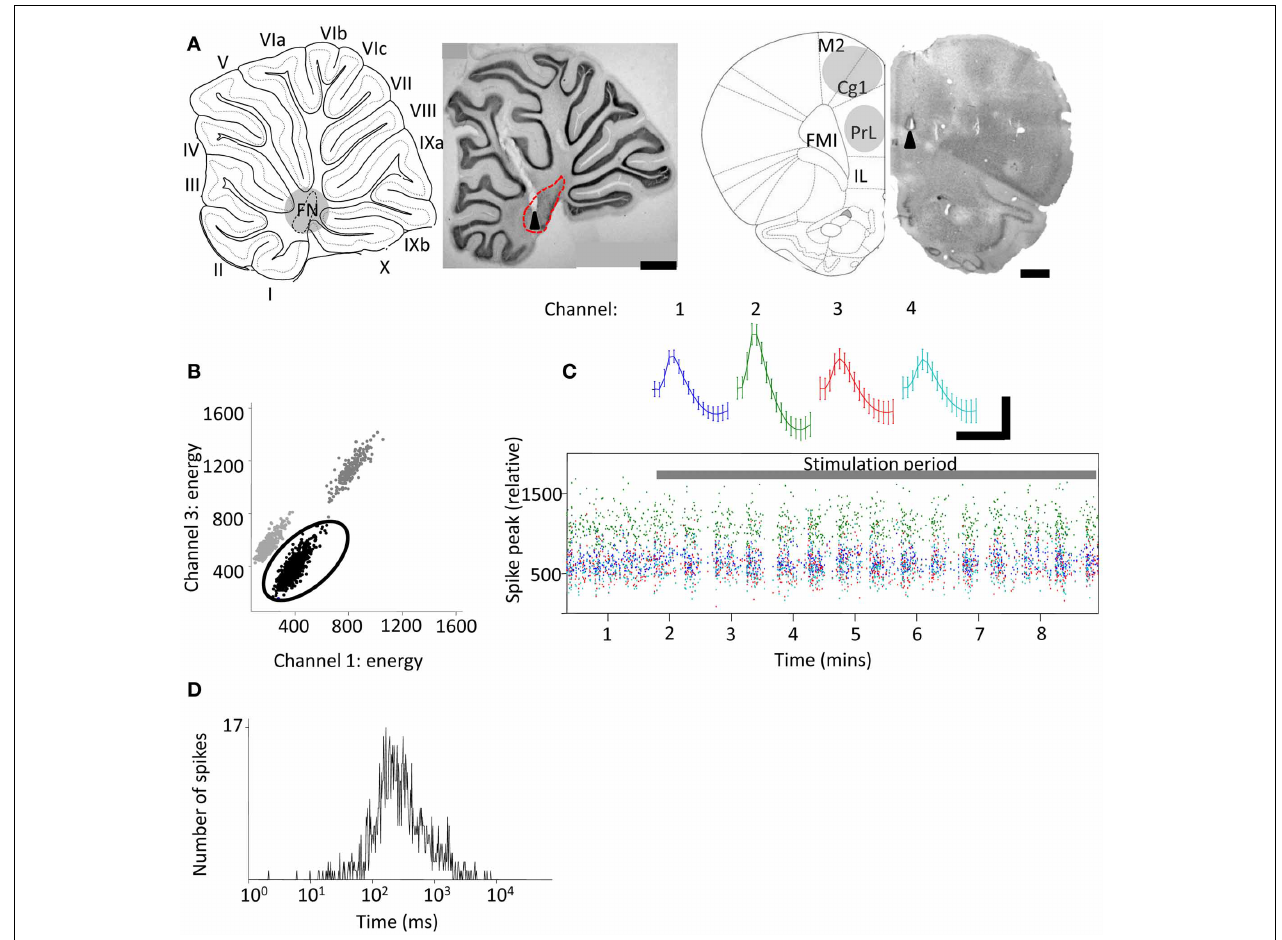
FIGURE 1 | Extracellular tetrode recordings of single-unit PrL activity during cerebellar stimulation. (A) Grouped schematic (shaded gray areas, adapted from Paxinos and Watson, 2006) and representative micrographs of neutral red-stained 50 μ m saggital and transverse brain slices showing respectively the sites of electrolytic lesions (arrowheads) in the cerebellum (left,) and PrL, right). Dashed lines indicate outline of fastigial nucleus and overlying cerebellar cortical lobules are numbered; scale bars, 1mm. M2, supplementary motor cortex; Cg1, cingulate cortex; IL, infralimbic cortex.